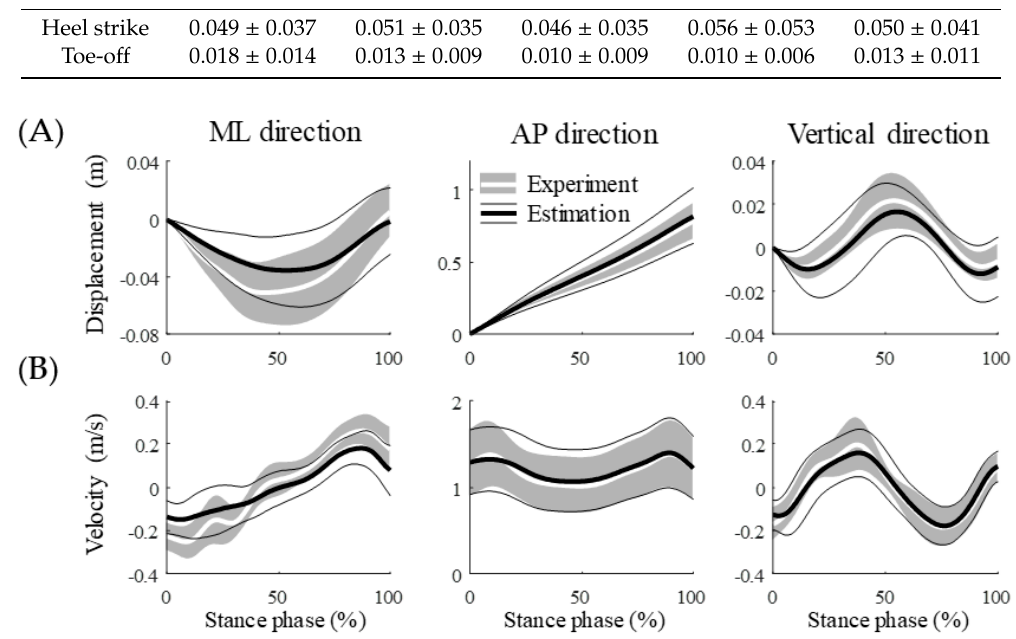
Figure 5. Average of the ( A ) displacement and ( B ) velocity of the sacrum during the stance phase for all walking speeds of all 17 participants. The averages and the standard deviations of the estimation results are represented by black thick and thin solid lines, respectively, and the average and standard deviations of the experimental data are represented by a white thick solid line and gray shade area,